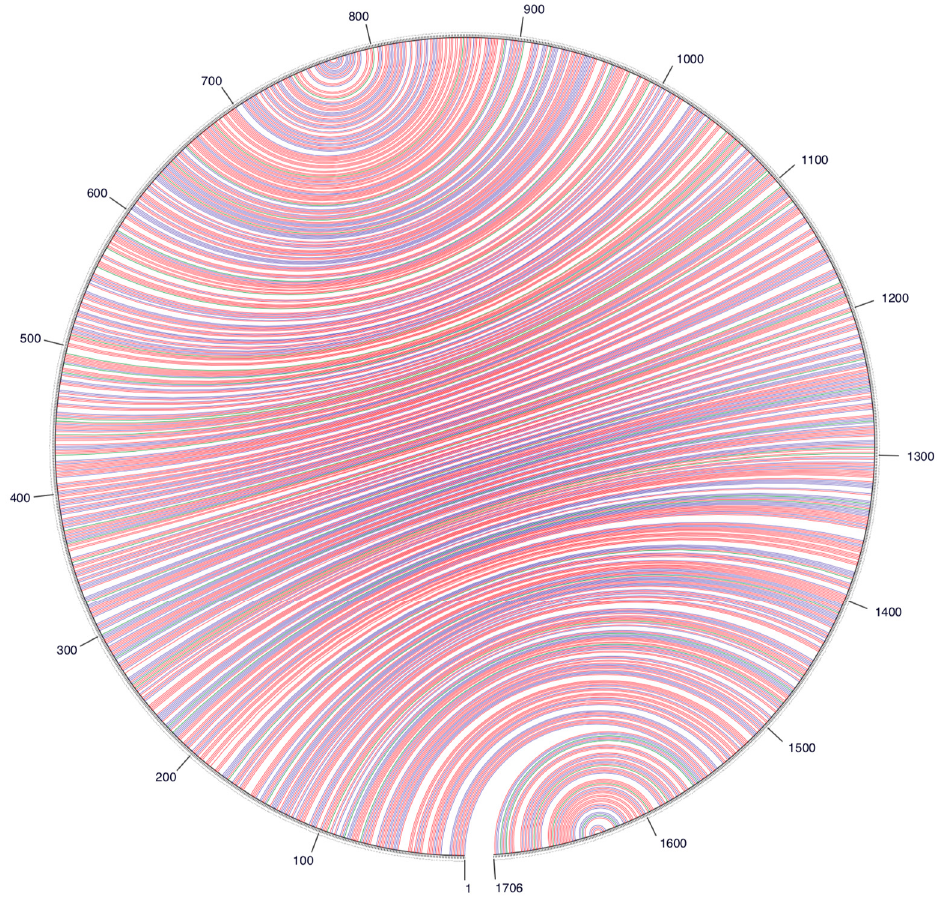
Figure 2. A circle graph showing the base pairing of the circular RNA genome structure of the avian HDV-like agent into an unbranched rod-like structure. The circle circumference represents the genome sequence, and the arcs represent the base pairing. Colouring of arcs: Red for G-C pairing, blue for A-U pairing, green for G-U pairing, and yellow for other types of pairings.